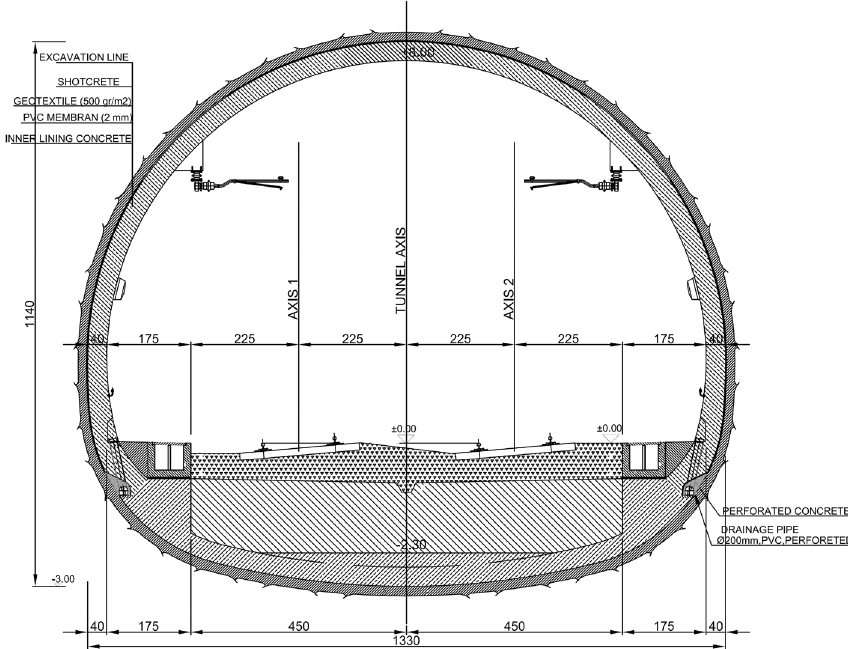
Figure 2. Typical cross-section of the T6 tunnel.